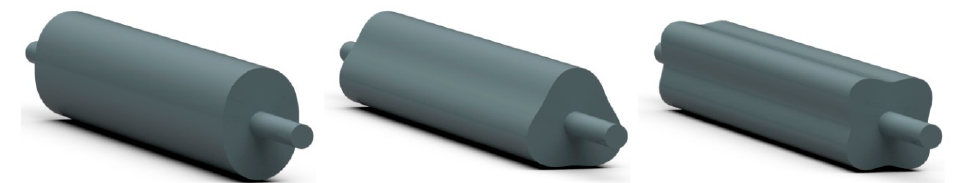
Figure 3. Rotors with a single roundness component. From left to right: second component, third component, and fourth component.